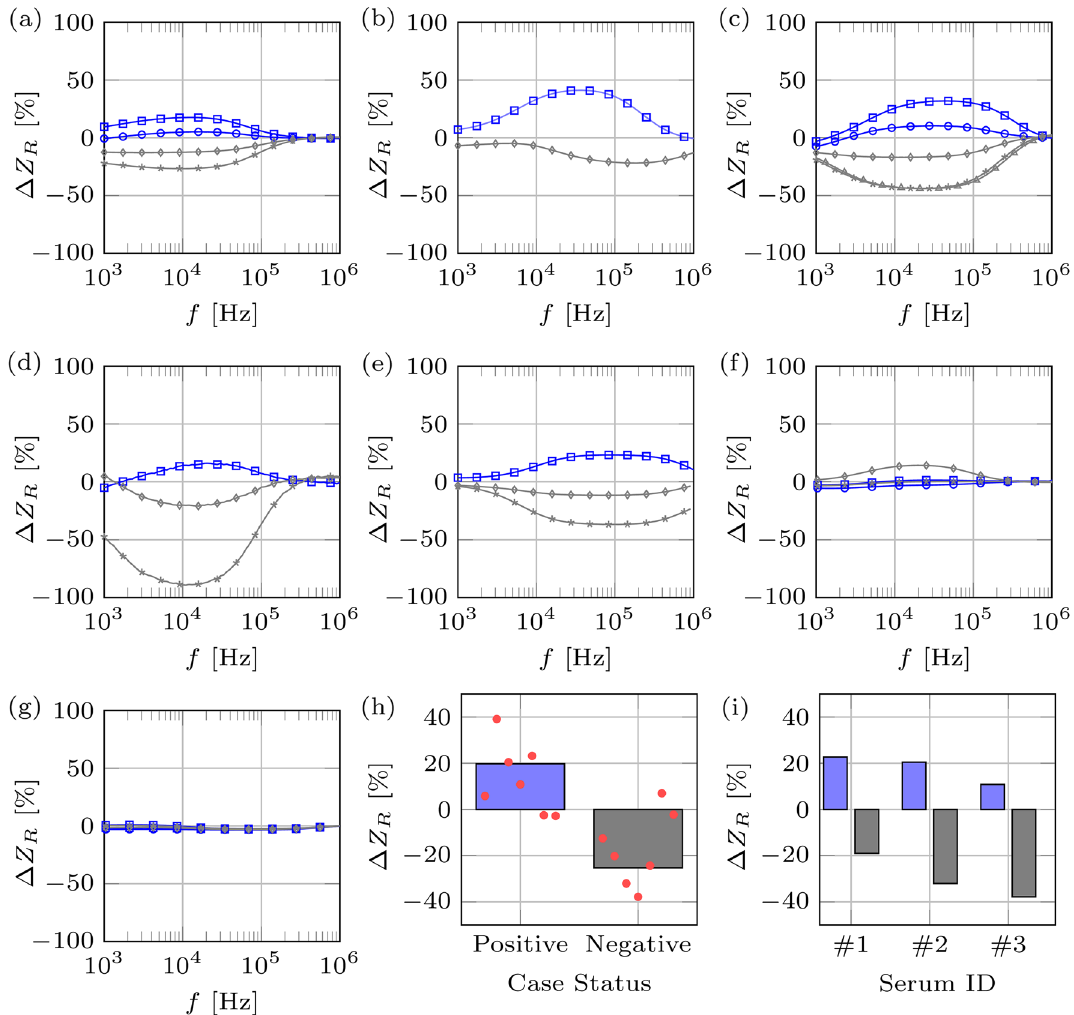
Figure 4. Impedance data collected from affinity biosensor chips after incubation with COVID-19 positive or negative sera followed by binding with GNP-protein G. ( a – e ) Impedance data collected from 5 different chips. The blue color indicates positive cases while the gray one indicates negative ones. Each curve corresponds to data collected from a single test. ( f , g ) two examples of failed tests, not able to distinguish between positive and negative sera. ( h )The impedance data, collected from positive or negative sera, tested on the same chips, was averaged and plotted as single points. ( i ) The impedance data collected from individual COVID-19 positive or negative sera from different chips, was